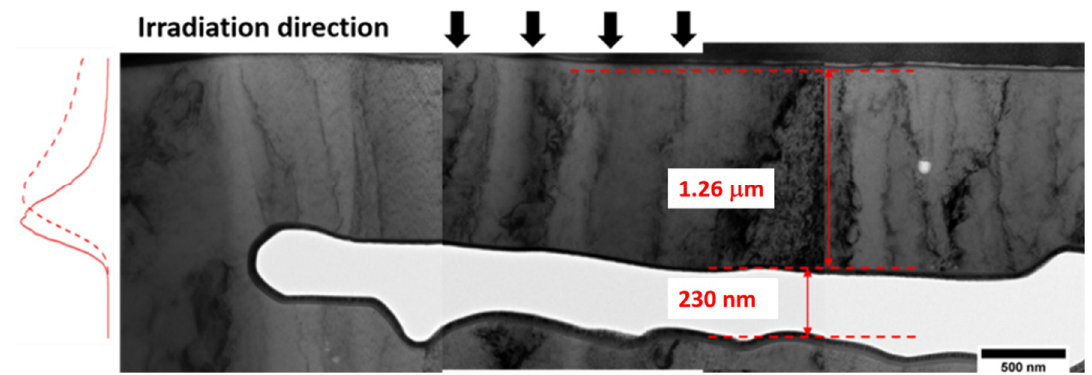
Figure 7. TEM micrograph of irradiated Fe containing a trench with an upper surface located at the depth 1.26 µ m, corresponding to just over the peak of the injected interstitial distribution.